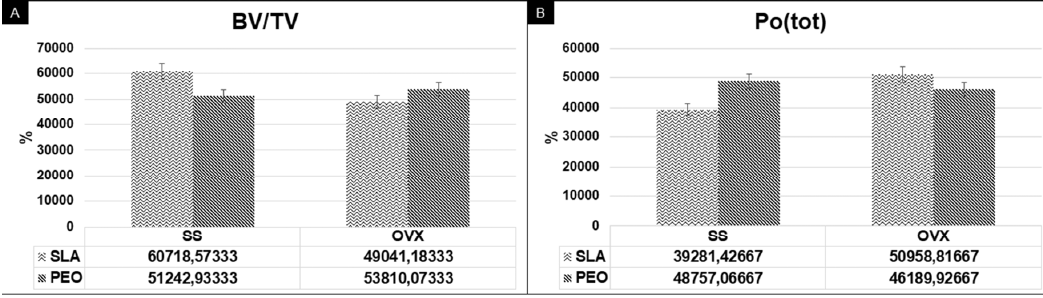
Figure 4. Microtomography parameters for bone quantitative parameters related to the amount of bone tissue (BV.TV) ( A ) and percentage of total porosity (Po. (tot)) ( B ) for SLA and PEO surface coating in groups SS and OVX at 60 days. There was no statistically significant difference among experimental groups.